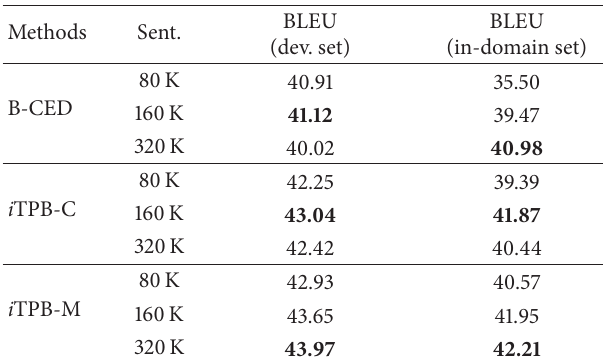
Table 4: Translation results of i TPB at different combination